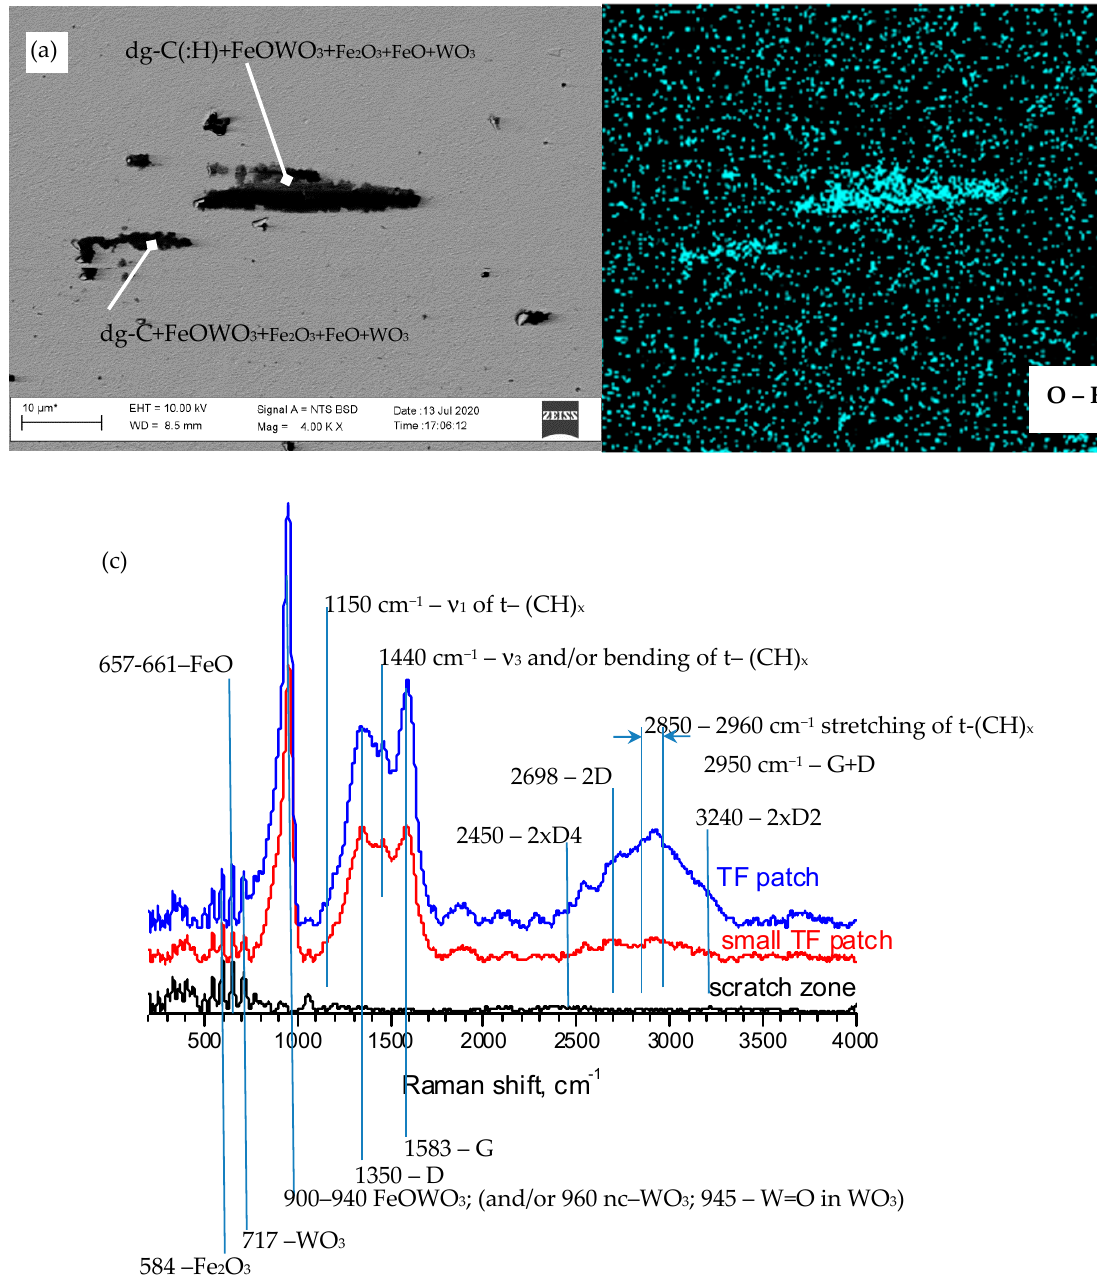
Figure 9. ( a ) Tribo-film (TF) patches in the wear track of non-hydrogenated W-C coating and ( b ) the corresponding map of oxygen; ( c ) Raman spectra taken from a tribo-film patches and scratch zone (reprinted with permission from Ref. [25], 2021, Elsevier).